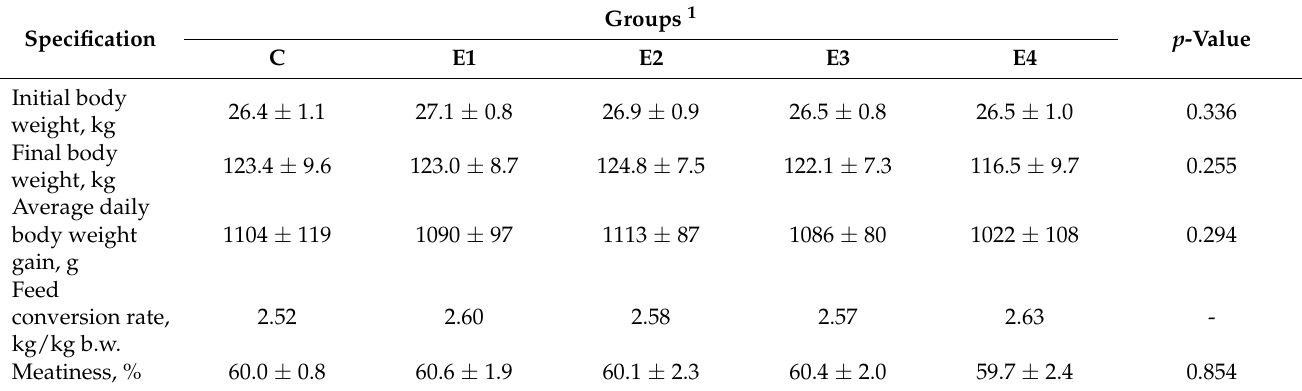
Table 5. Fattening and carcass results of pigs in experiment, ( x ± SD).